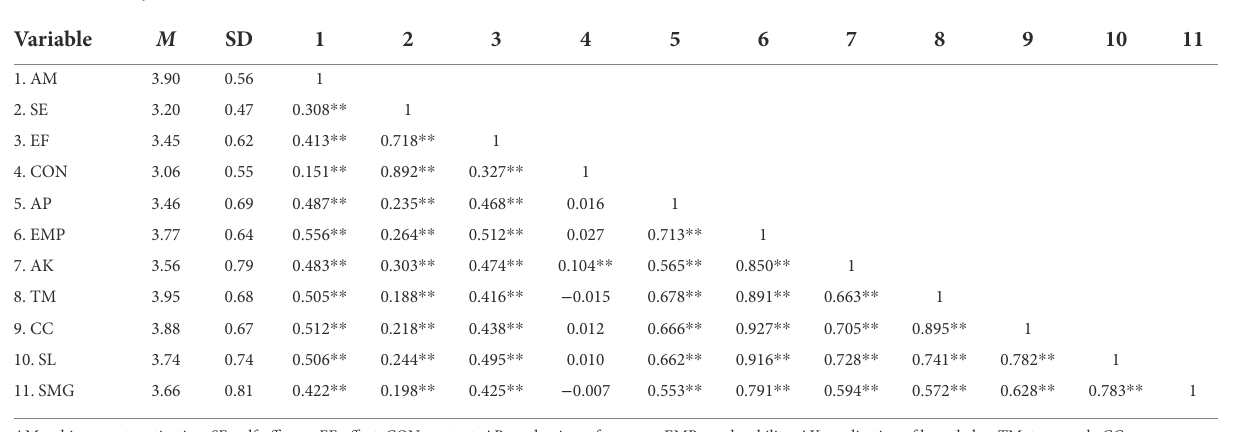
TABLE 4 Means, standard deviations and correlations between